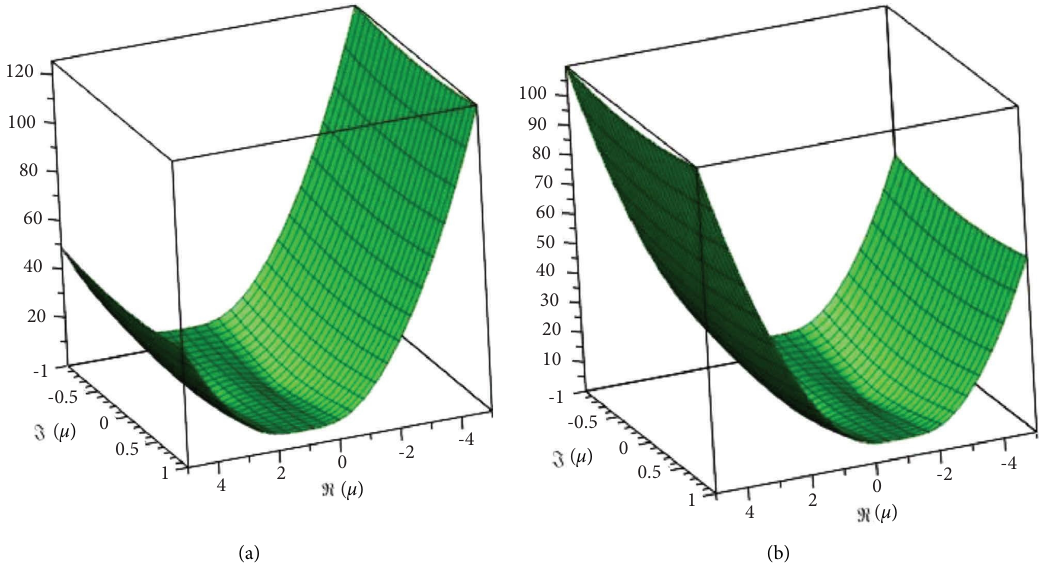
Figure 7: For varying Z and η values, the spreading level of ailing cases is decreasing and then increasing slowly (a) D